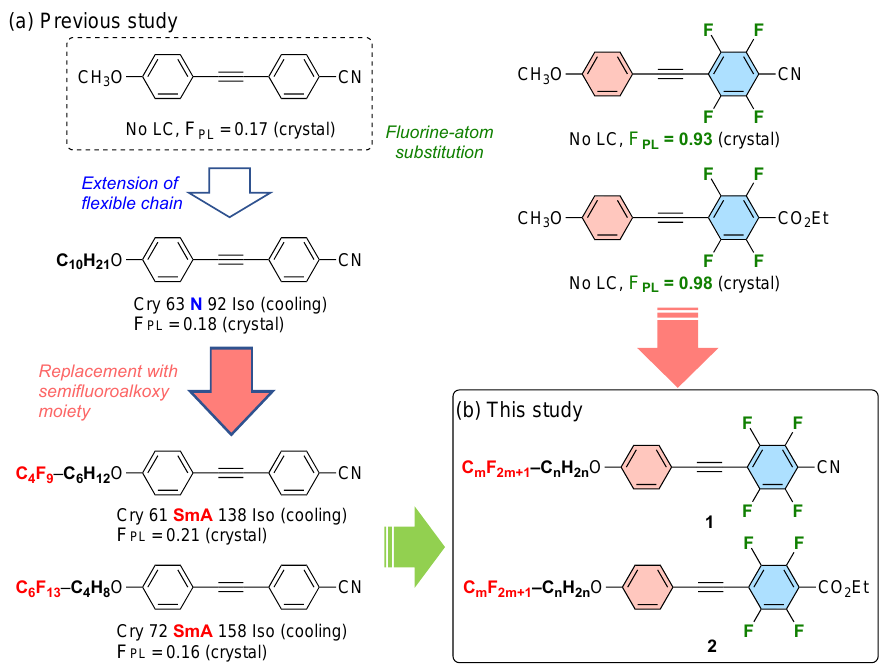
Figure 2. ( a ) Chemical structures and representative properties of molecules reported in our previous study and ( b ) chemical structures of semifluoroalkoxy-containing D- π -A-type fluorinated tolanes 1 and 2 developed in the present work.